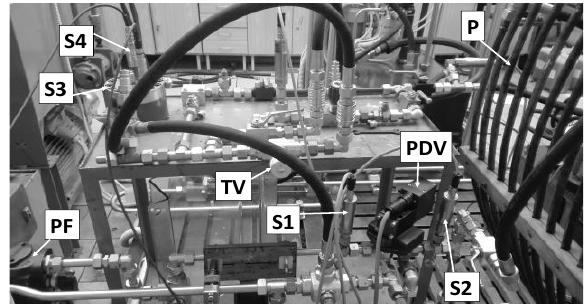
Fig. 1. Experimental